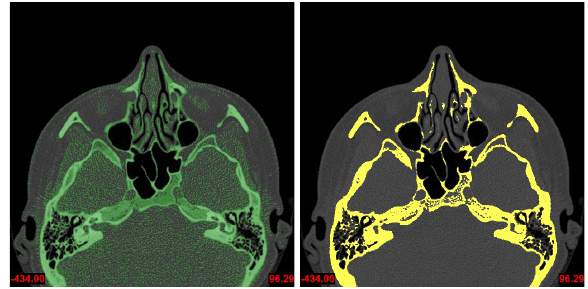
Figure 3. Using the connected area selection function to remove noise on